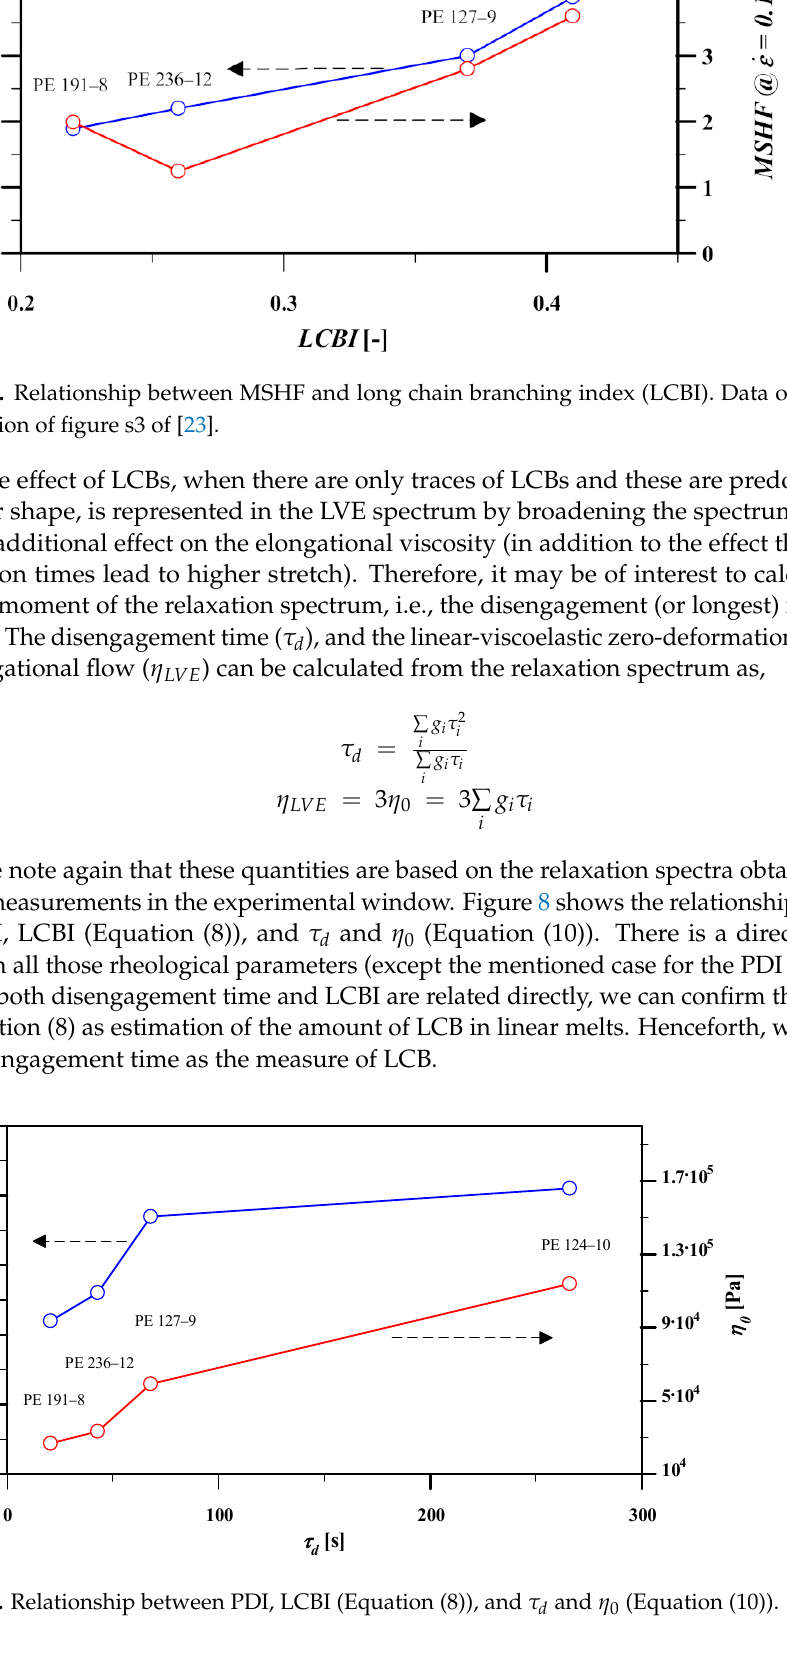
Figure 8. Relationship between PDI, LCBI (Equation (8)), and d